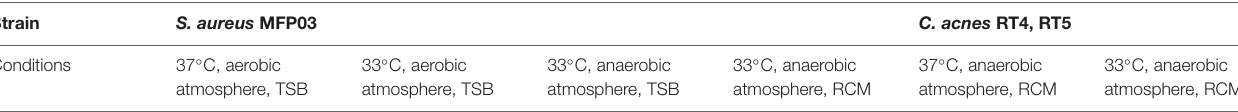
TABLE 1 | Conditions of monospecies biofilm cultivation for CLSM